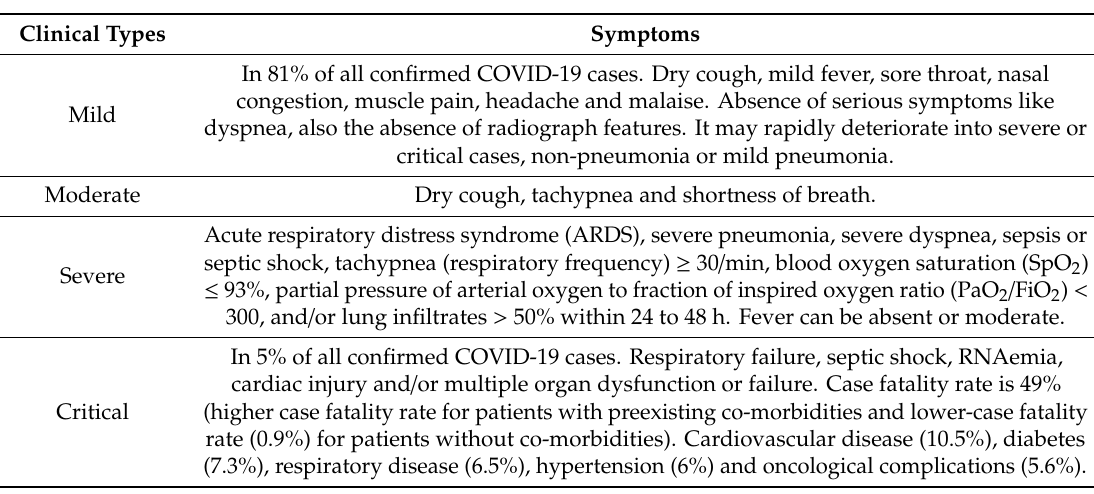
Figure 6. Organ involvement confirmed by clinical features or bioptic sampling in COVID-19 patients ( A ). Table describing main observed disorders ( B ). Table 4. Clinical manifestations of COVID-19.